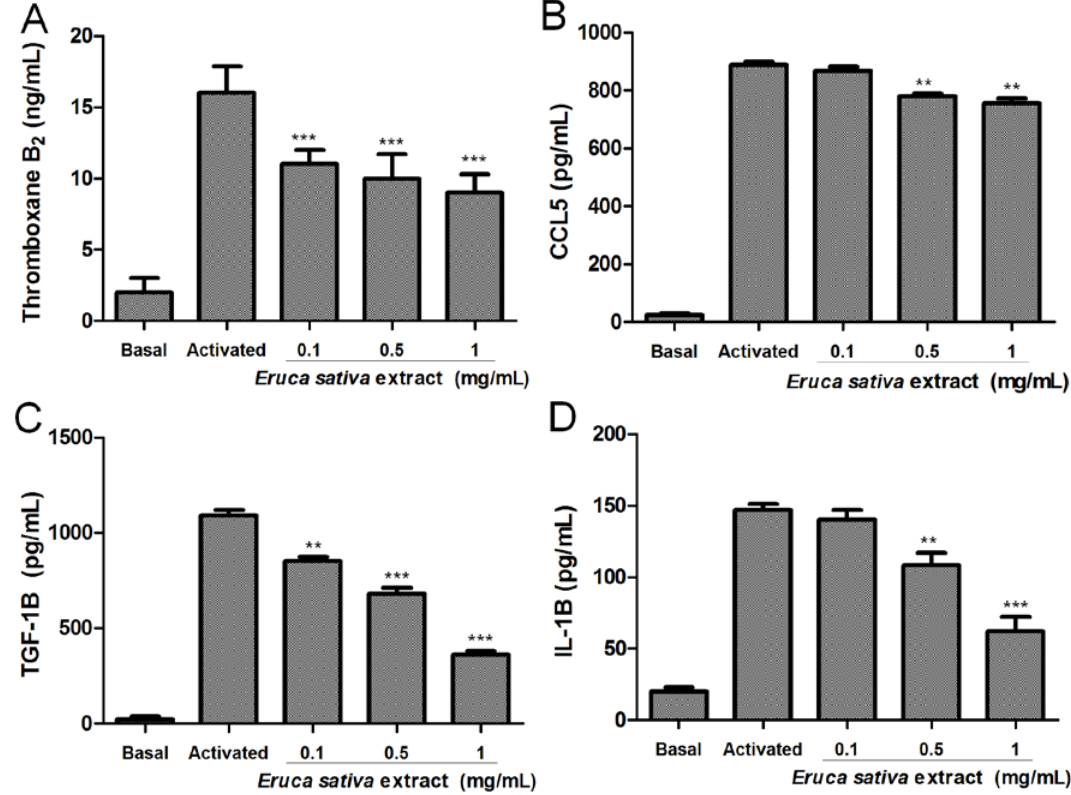
Figure 3. Effects of Eruca sativa Mill. extract on the release of thromboxane B 2 ( A ), CCL5 ( B ), TGF-β1 ( C ) and IL-1β ( D ) induced by ADP (8 μmol/L) from human platelets. The graph depicts the mean ± SEM of n = 6 experiments. ** p < 0.01 and *** p < 0.001 indicates differences when compared with activated control, analyzed by one-way ANOVA and Tukey’s post hoc